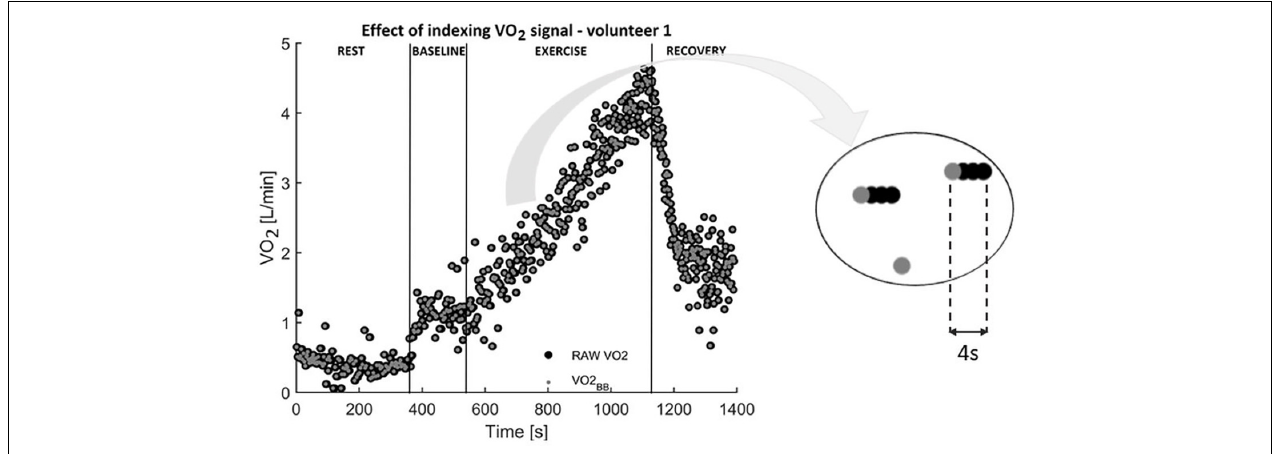
FIGURE 1 | Original oxygen uptake signal (black) was limited to only the first recorded VO 2 value of each breath. As a result, a new VO 2_BB signal sampled irregularly (gray) was obtained.